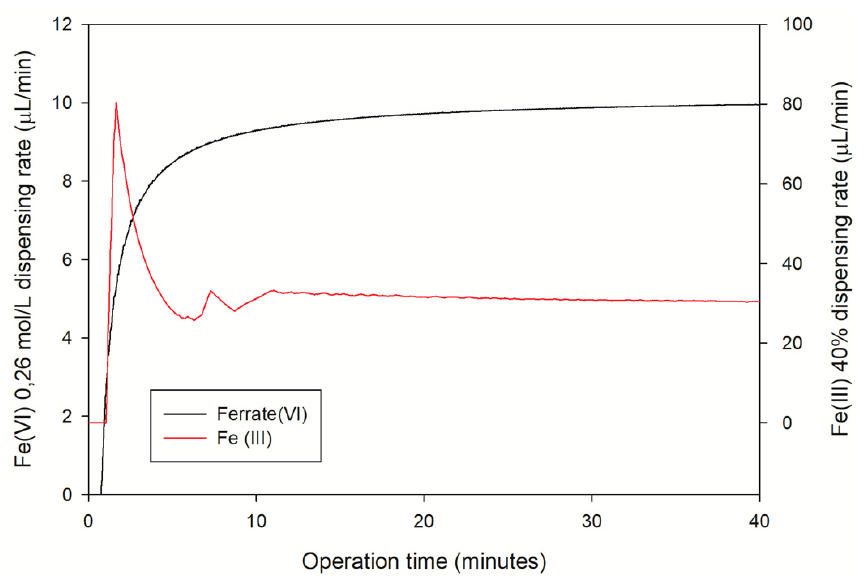
Figure 5. Fe(VI) and Fe(III) instantaneous dosing during treatment. Figure 4. Fe(VI) and Fe(III) instantaneous dosing during treatment.